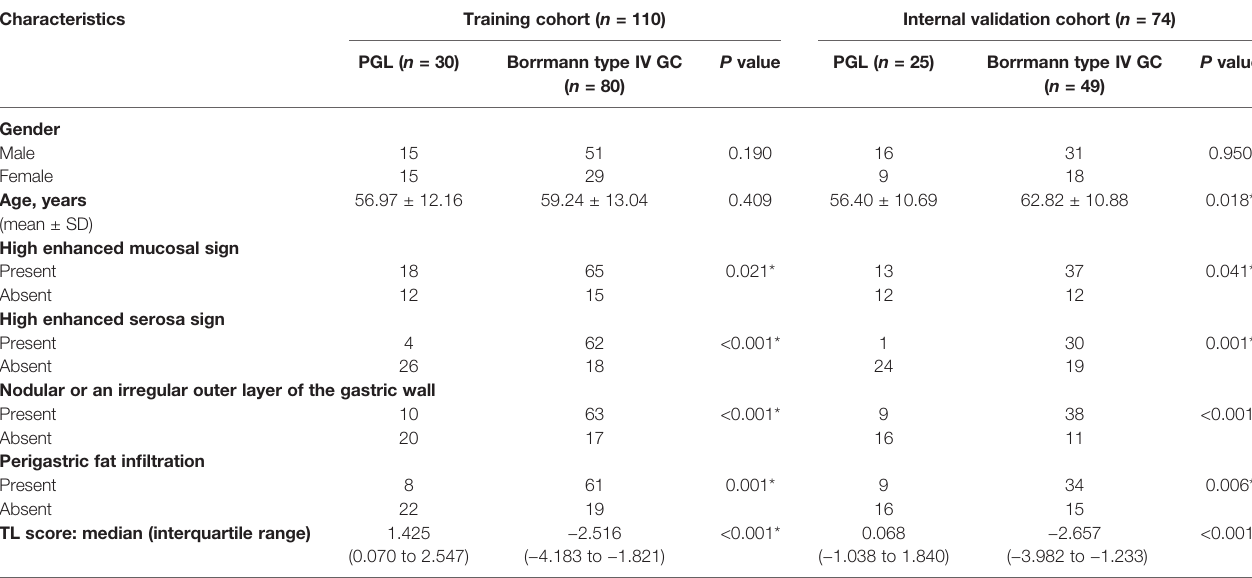
TABLE 1-1 | Clinical characteristics of PGL and Borrmann type IV GC patients in the training and internal validation cohorts. Characteristics